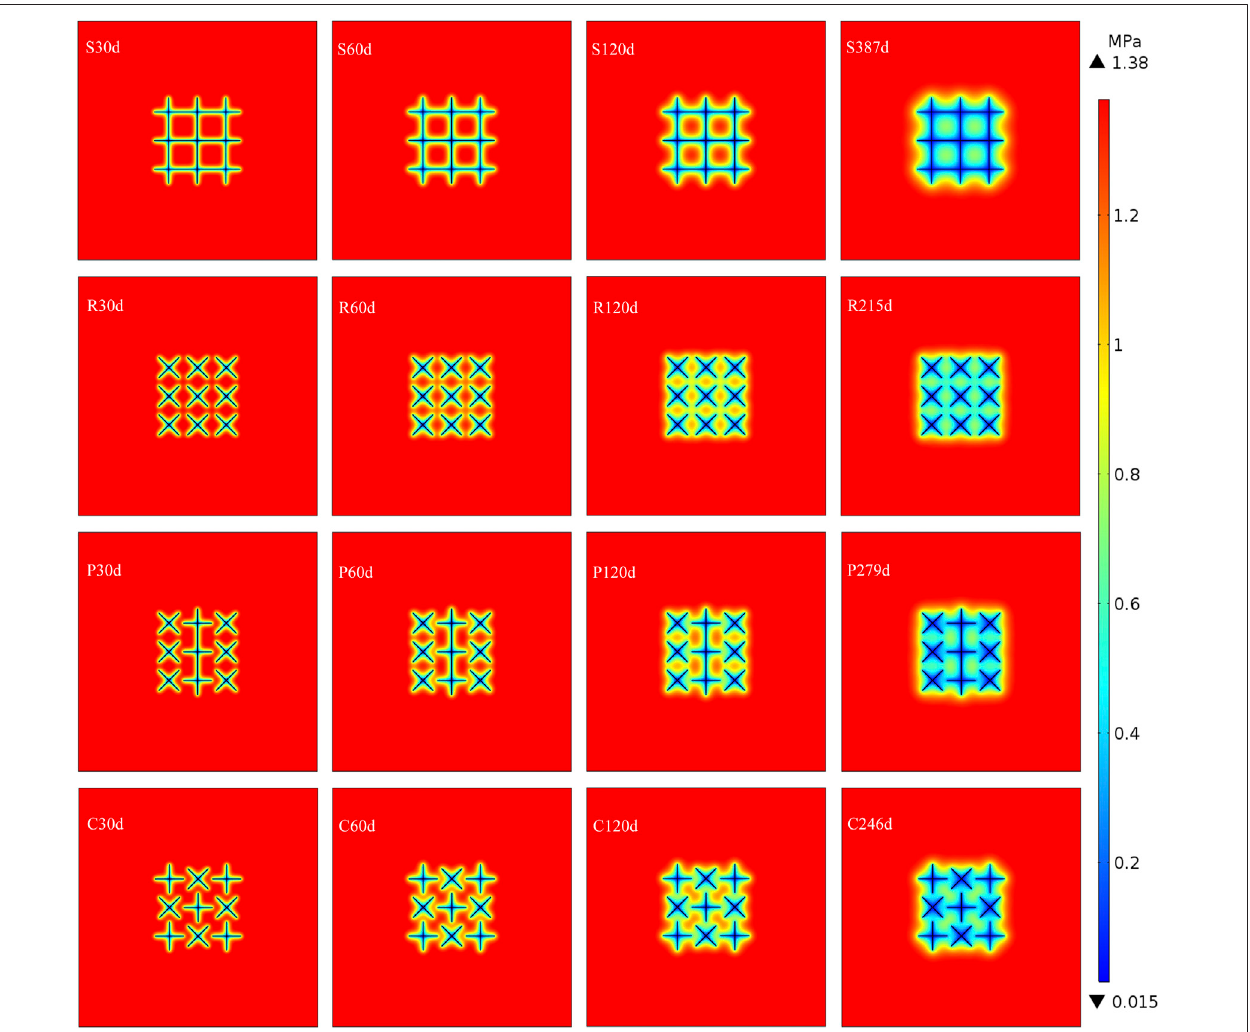
FIGURE 4 | Methane pressures in a mode coal seam at different times during coal mine methane drainage by multiple tree-type boreholes with different sub- borehole con fi gurations.